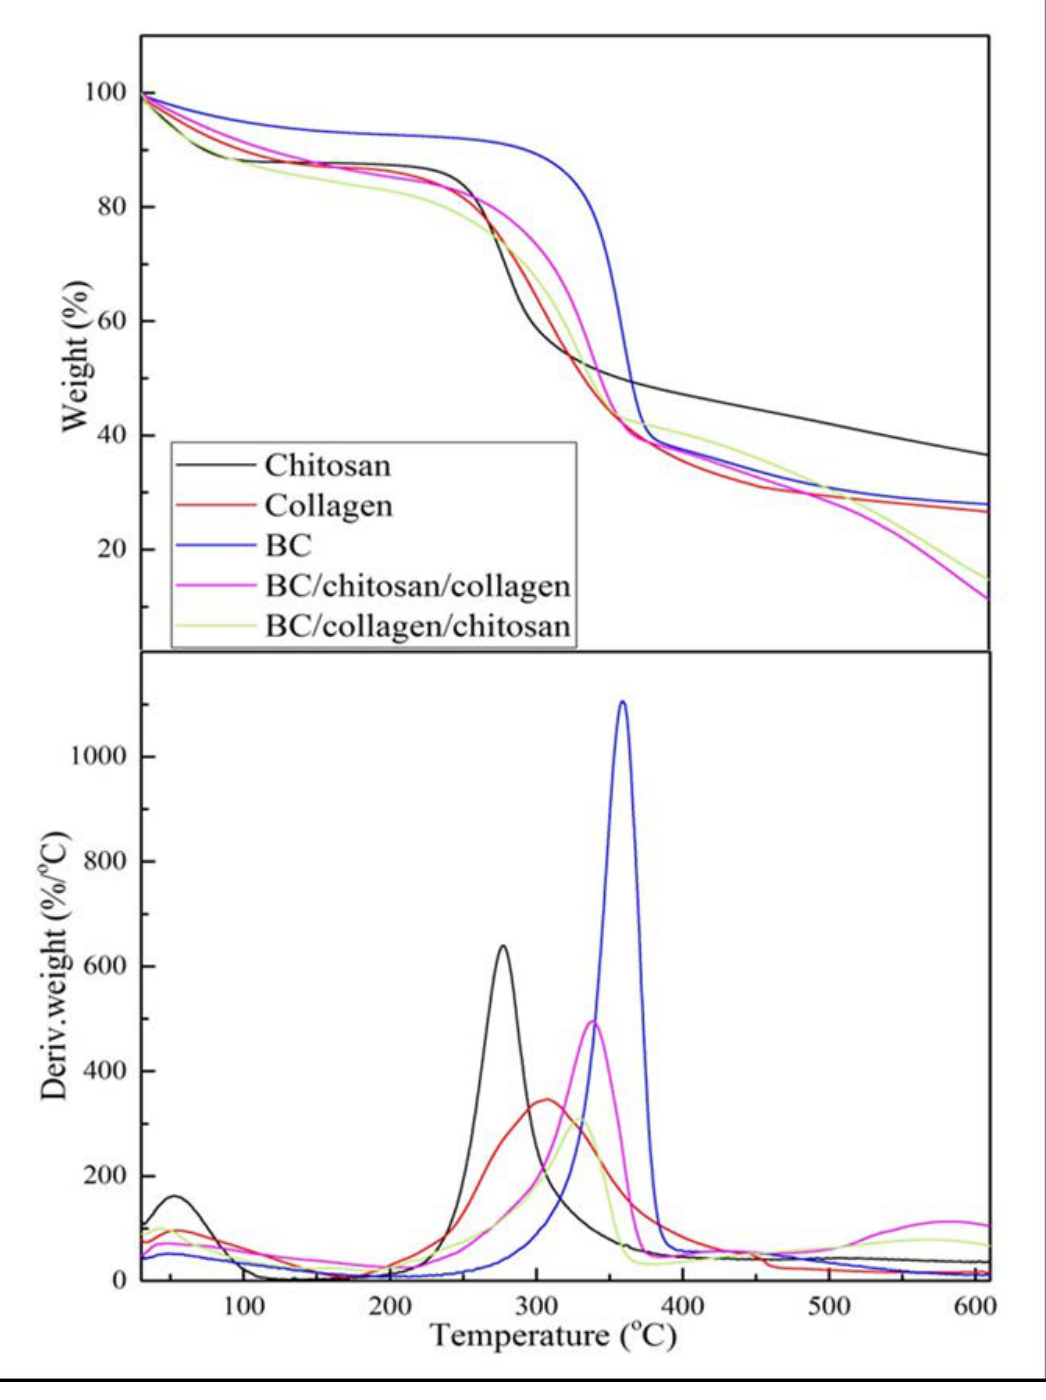
Figure 5. ( a ) TGA and ( b ) DTGA